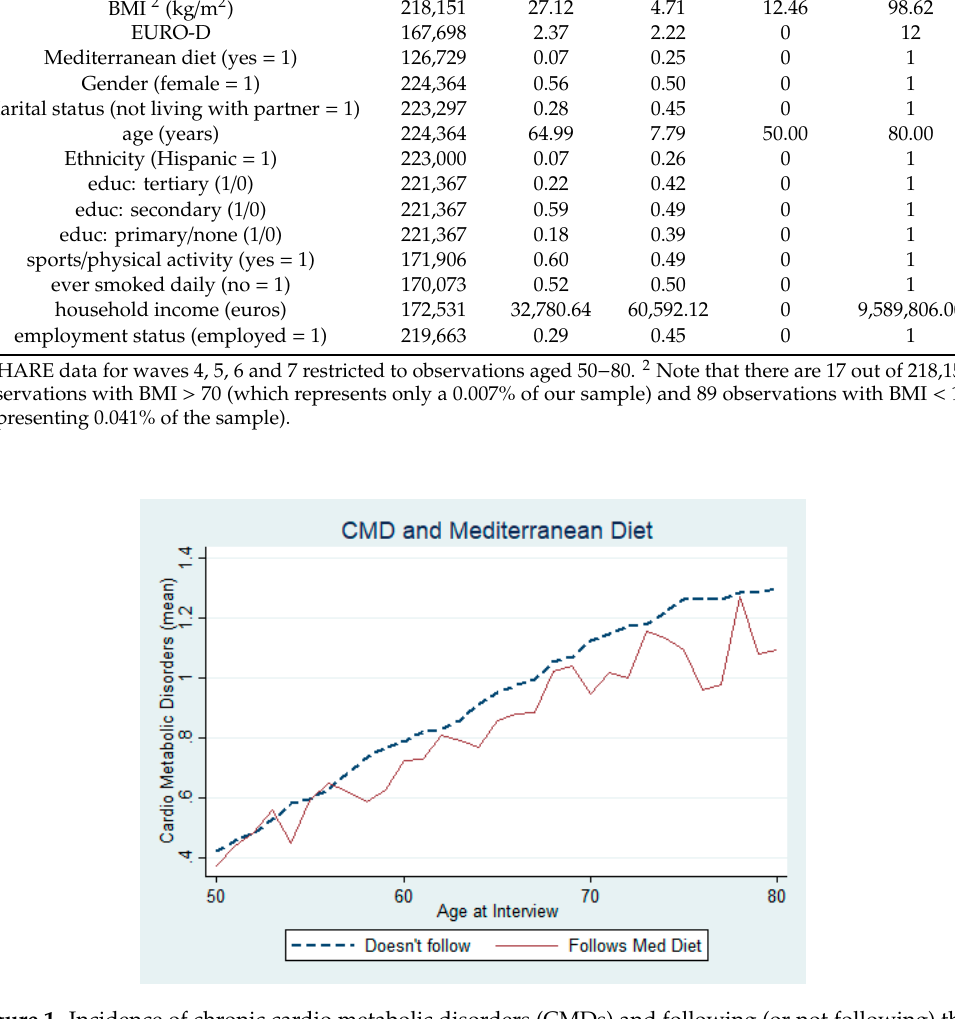
Table 1. Descriptive statistics of key variables 1 .